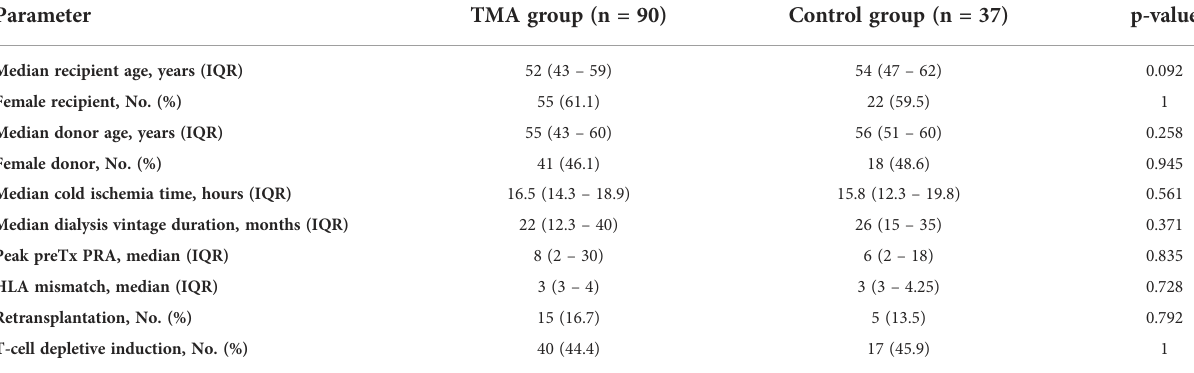
TABLE 1 Basic characteristics and